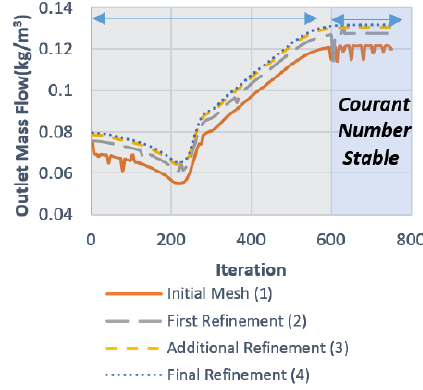
Figure 10. Mass flow rate convergence graph.